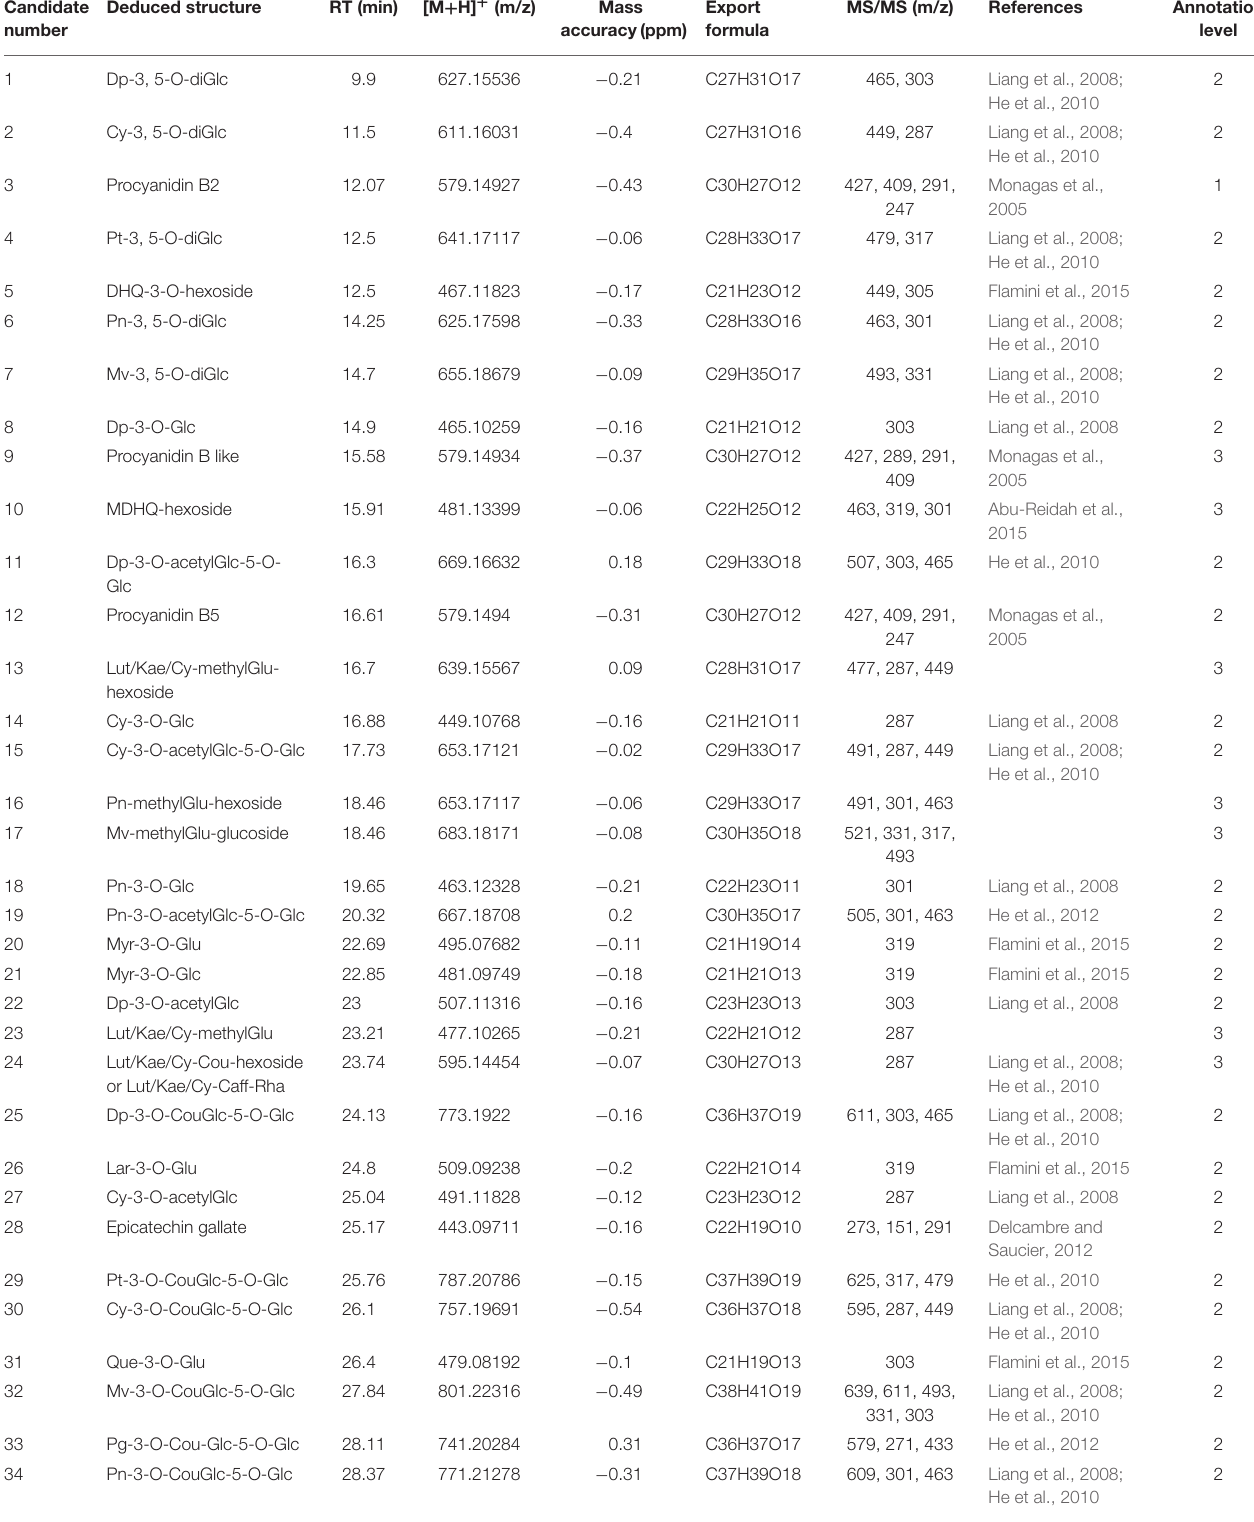
TABLE 1 | Flavonoids annotated from LC-MS data of developing grape berries. Candidate